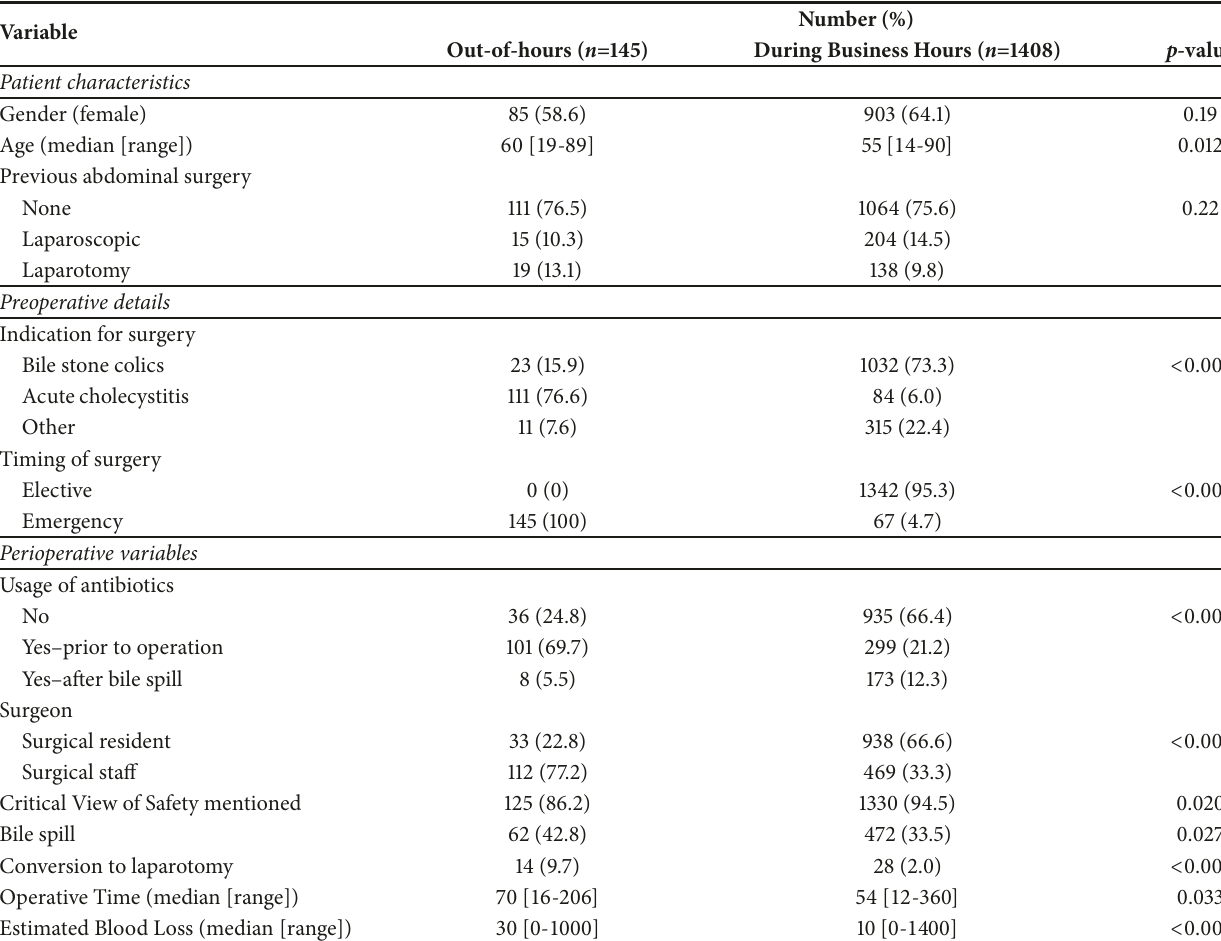
Table 2: Patient clinicopathologic and operative characteristics; comparing out-of-hours procedures to those during business hours.